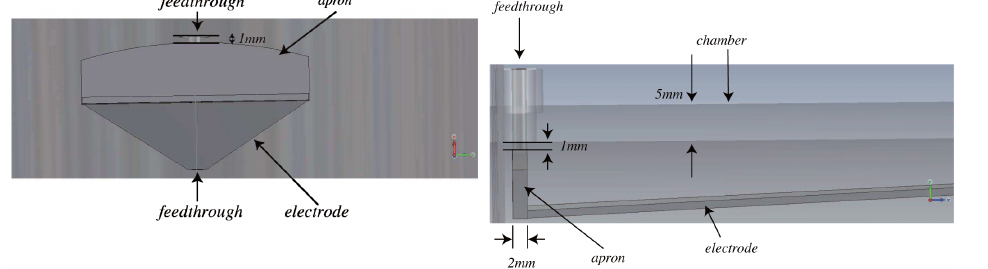
apron.FIG. 10. The simulation model of the